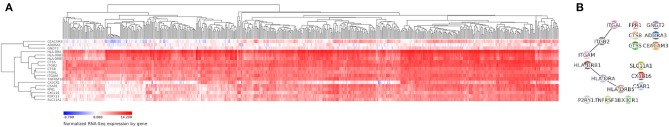
Vizome database analysis. We verified the expression levels of hub genes in the Vizome database by heatmap (A) and gene-interaction plot (B).